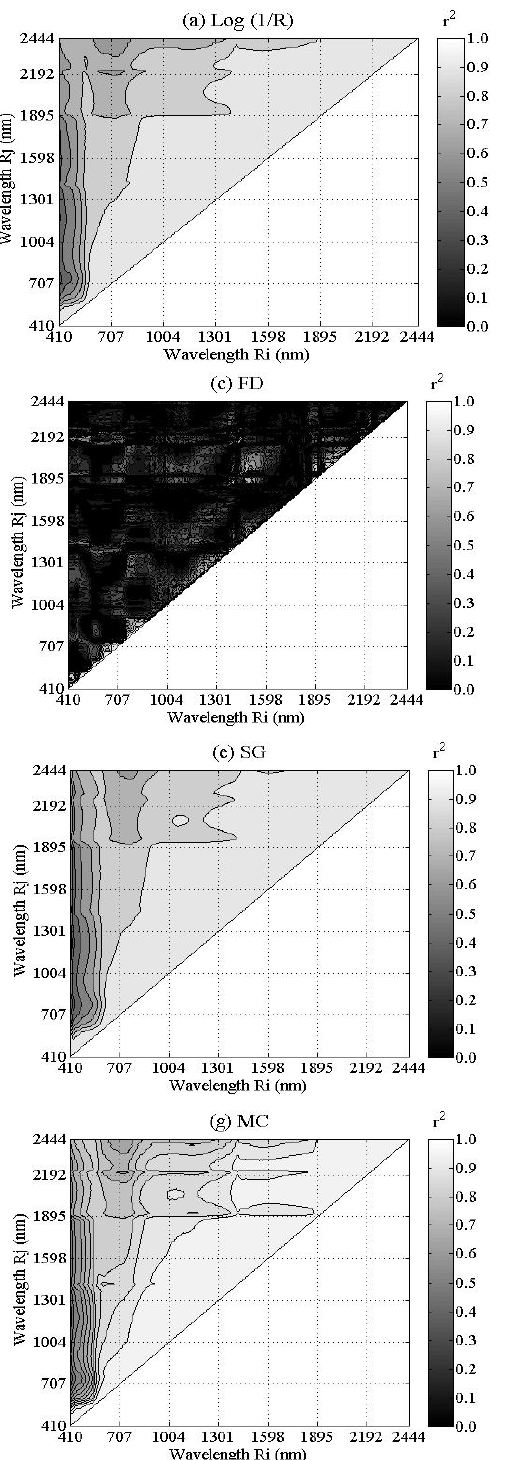
Figure 4. The correlation coefficient contour plots of different wavelengths of pre-processed spectra (( a ) Log (1/R); ( b ) Log (1/R) + SG; ( c ) first derivative with SG smoothing (FD); ( d ) second derivative with SG smoothing (SD); ( e ) Savitzky-Golay smoothing (SG); ( f ) standard normal variate (SNV); ( g ) mean center (MC); and ( h ) multiplicative scatter correction